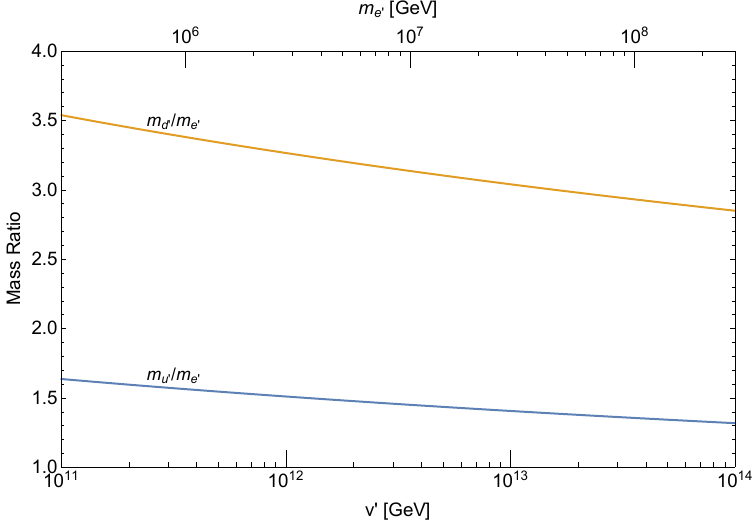
Figure 4 . Masses of the lightest charged mirror fermions, e